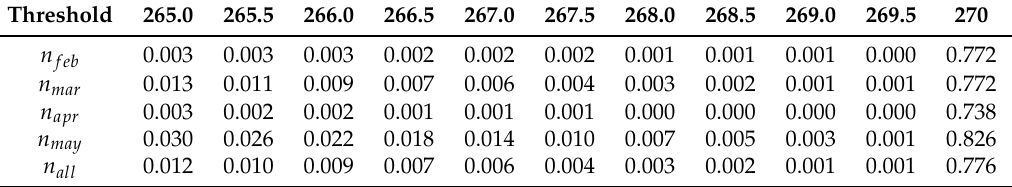
Figure 12. Uncertainty of MODIS SIC per granule. The panels show the mean ( a ) and the 99th percentile ( b ) for each granule. Panel ( c ) shows the “additionally discarded values”, i.e., the absolute difference between the fraction of values which would be discarded by the respective threshold and the fraction of values would be discarded by the highest threshold. The markers in the panels show the respective parameter for different thresholds between 265 and 270K, where ice tie-point values above the respective threshold are discarded. The x-axis shows the date, the vertical lines mark the days with Sentinel-2 scenes. Table 4. Number of additionally discarded pixels for each threshold, normalised to the number of pixels in one MODIS granule. “Additionally discarded” means the increase in the number of discarded pixels compared to the number of pixels which the highest (i.e., most conservative) threshold, 270K, would have discarded. The numbers are absolute values, i.e., an additionally discarded fraction of 0.003 for the lowest threshold, 265K, in February means an increase from 0.772 (77.2% of all pixels) to 0.775 (77.5% of all pixels). For the highest threshold of 270K, the absolute of discarded pixels are